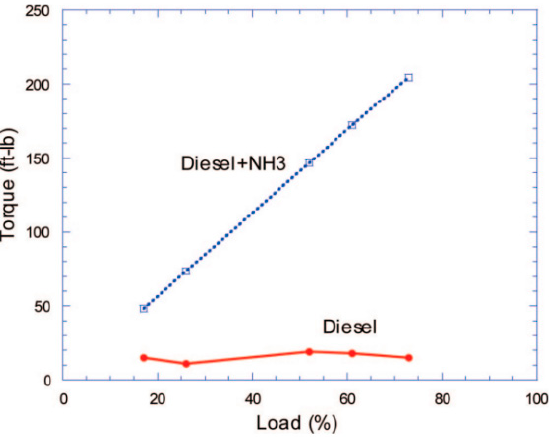
Figure 9. Torque conditions at different loads and fixed diesel injection volumes.